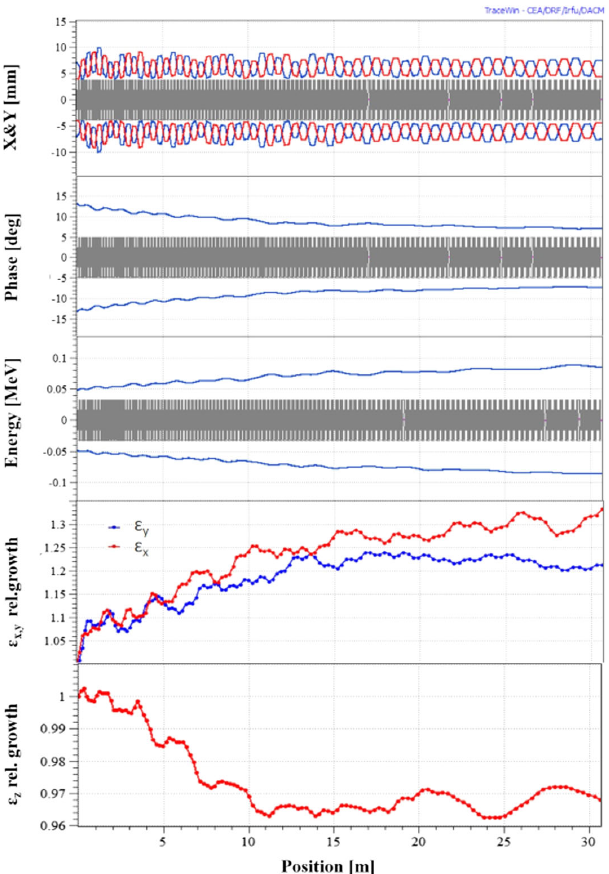
FIG. 7. Beam envelopes, transverse, and longitudinal rms- emittance growth for the prolonged cavity, k 0 ;t ¼ 65 °, k ¼ 120 °. 0 ;z